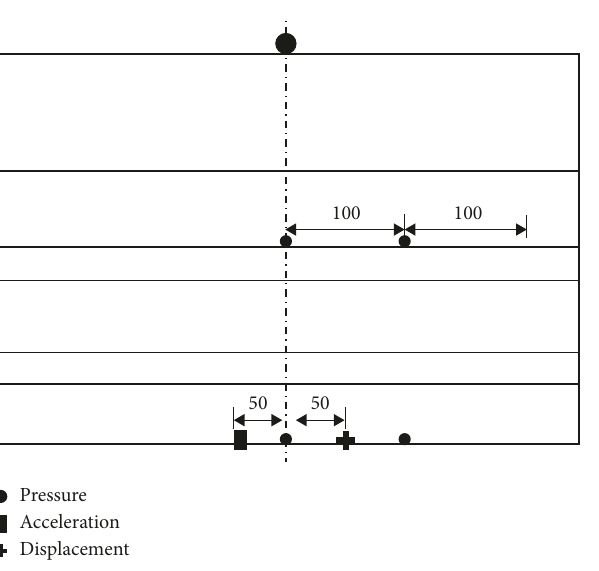
Figure 10: Arrangement of the measurement points in Test 5.